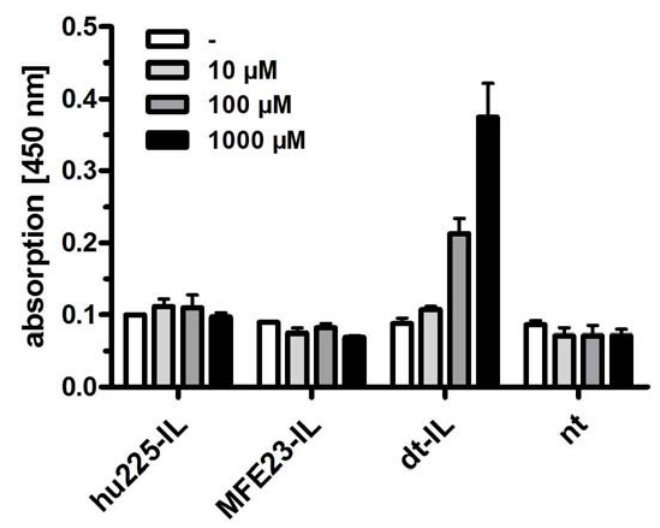
Figure 6. ELISA analyzing the binding of monospecific ILs (hu225-IL, MFE23-IL), dual-targeted immunoliposomes (dt-ILs) as well as non-targeted liposomes (nt) to immobilized CEA and detection of bound liposomes by incubation with EGFR-Fc and an anti-Fc antibody. Only the dt-ILs caused a signal confirming